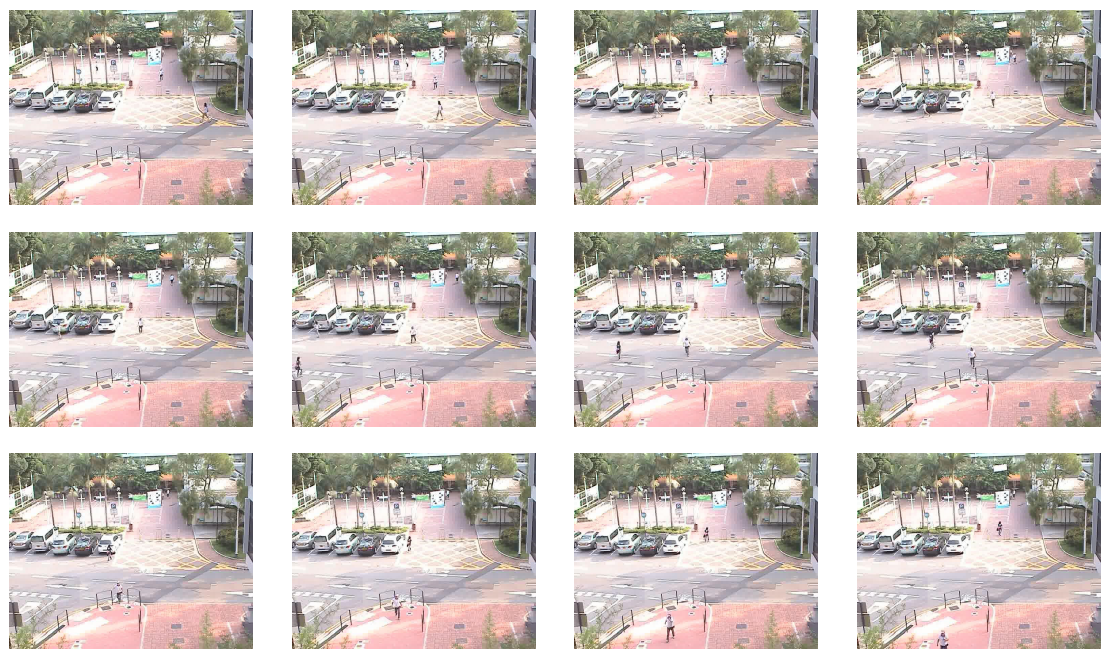
Figure 5. The adjacent frames extracted from a traffic video sequence, recorded by a stationary